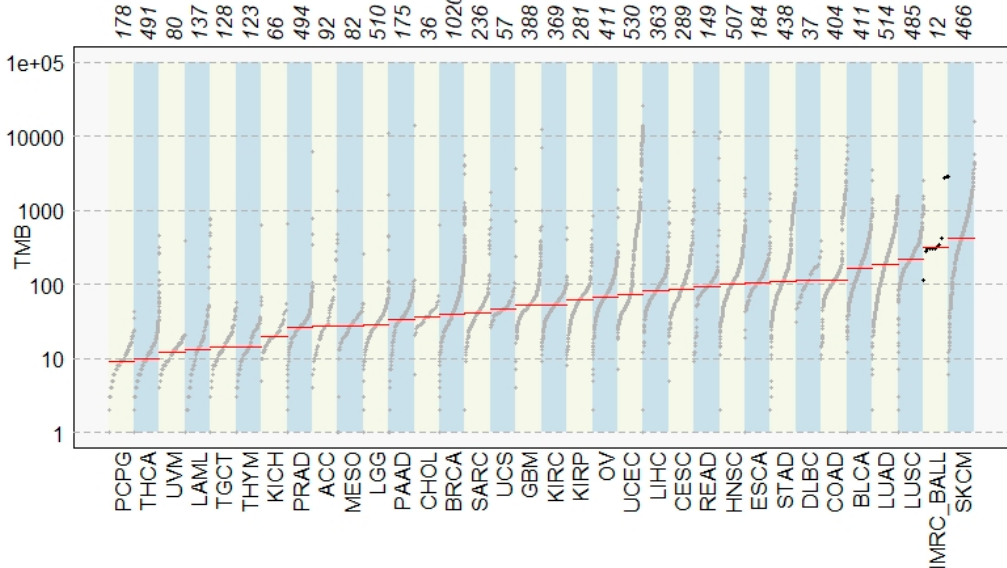
Figure 3. Comparison of mutational load with TCGA datasets. The Y-axis shows the number of mutations per mega base pair of the genomic sequence. The mutational load of the KAIMRC_BALL dataset from this study is the second largest, showing similarity with Skin Cutaneous Melanoma (SKCM), Lung squamous cell carcinoma (LUSC), Lung adenocarcinoma (LUAD), Bladder Urothelial Carcinoma (BLCA), Colon adenocarcinoma (COAD), and most importantly with Diffuse Large B-cell Lymphoma (DLBC).